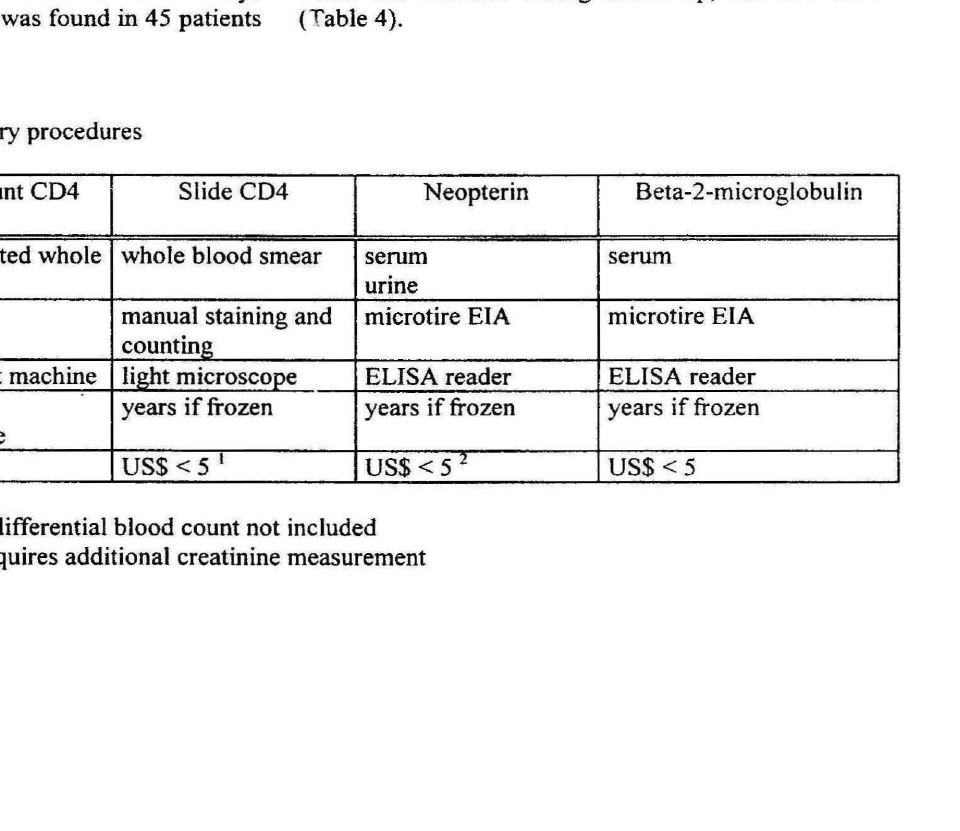
Table 1: Summary of laboratory